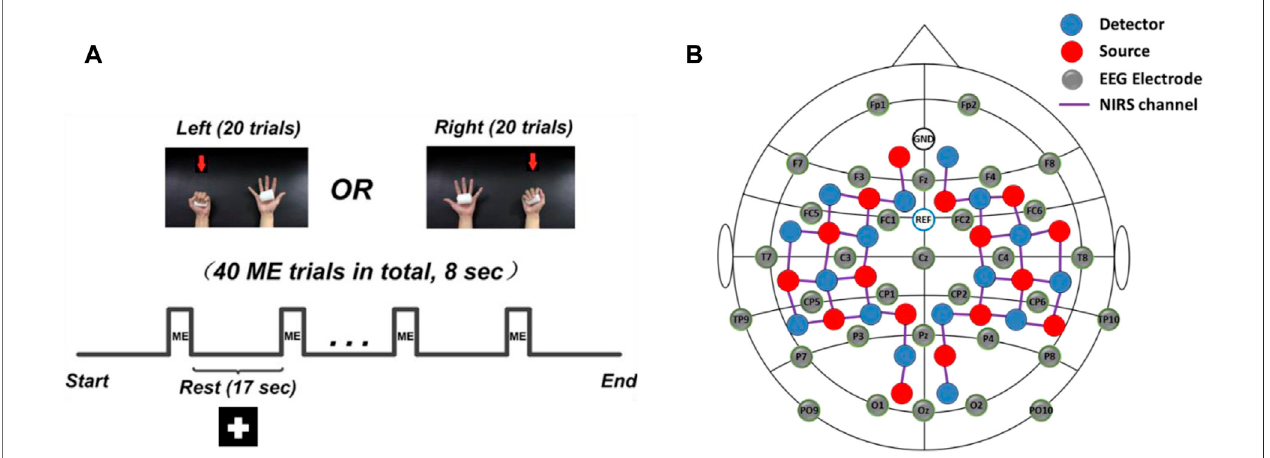
FIGURE 1 | Experimental design. (A) The experimental motor executive task used in the study. The “ ME ” represents motor execution. (B) The EEG and fNIRS channel locations.